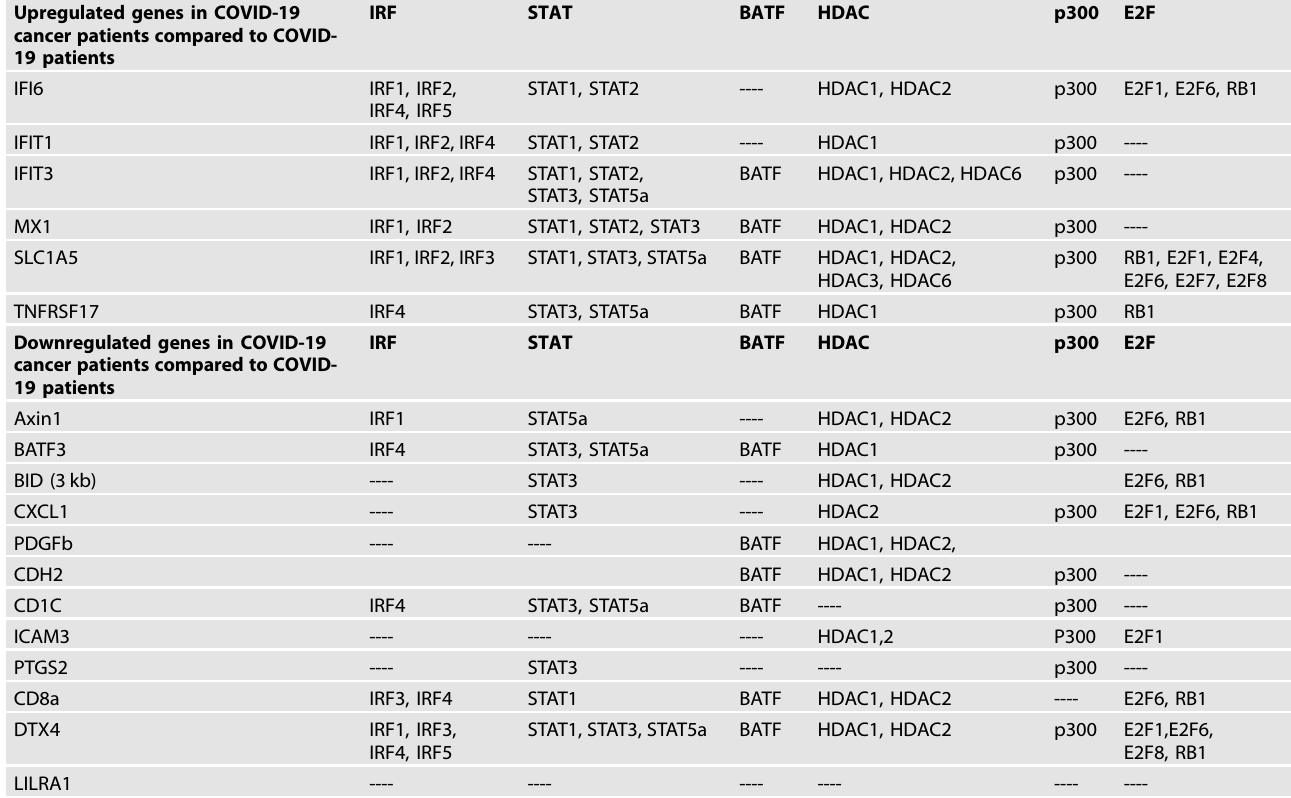
Table 1. Binding of IRF, STATs, BATF, HDACs, p300 and E2Fs to the regulatory region of upregulated and downregulated genes speci fi cally modulated in COVID-19 cancer patients compared to COVID-19